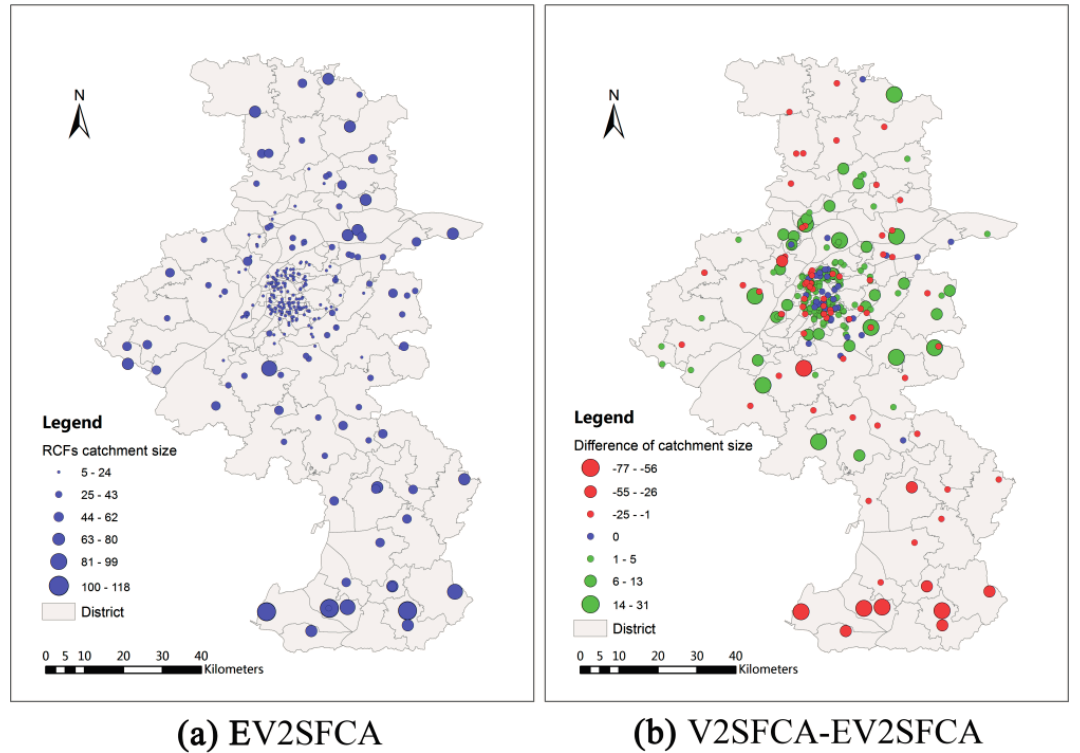
Figure 3. Facility catchment sizes calculated by EV2SFCA method ( a ) and facility catchment size differences between V2SFCA and EV2SFCA methods ( b ).